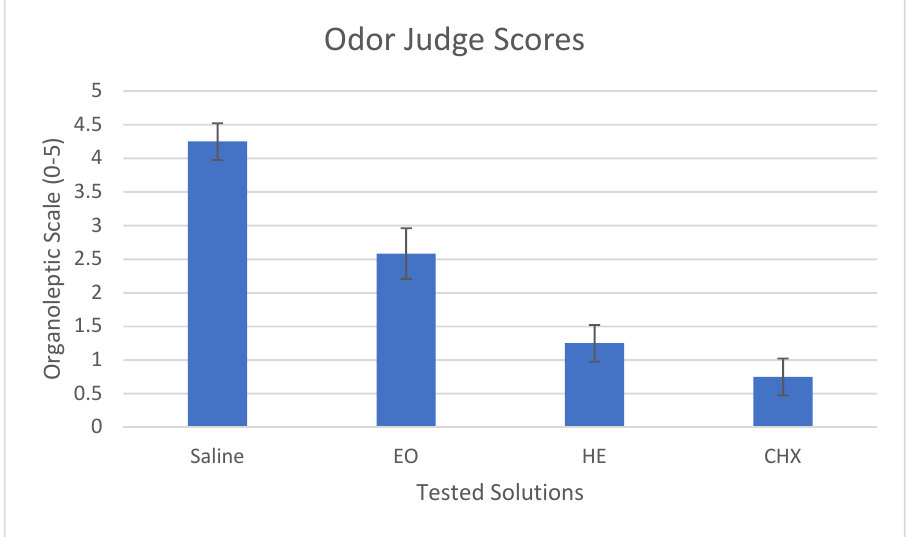
Figure 1. The mean results (±SD) of the odor judge scores given using an organoleptic scale of 0–5, for the various tested solutions: Saline, essential oils (EO), herbal extracts (HE), and chlorhexidine (CHX) formulations as indicated.